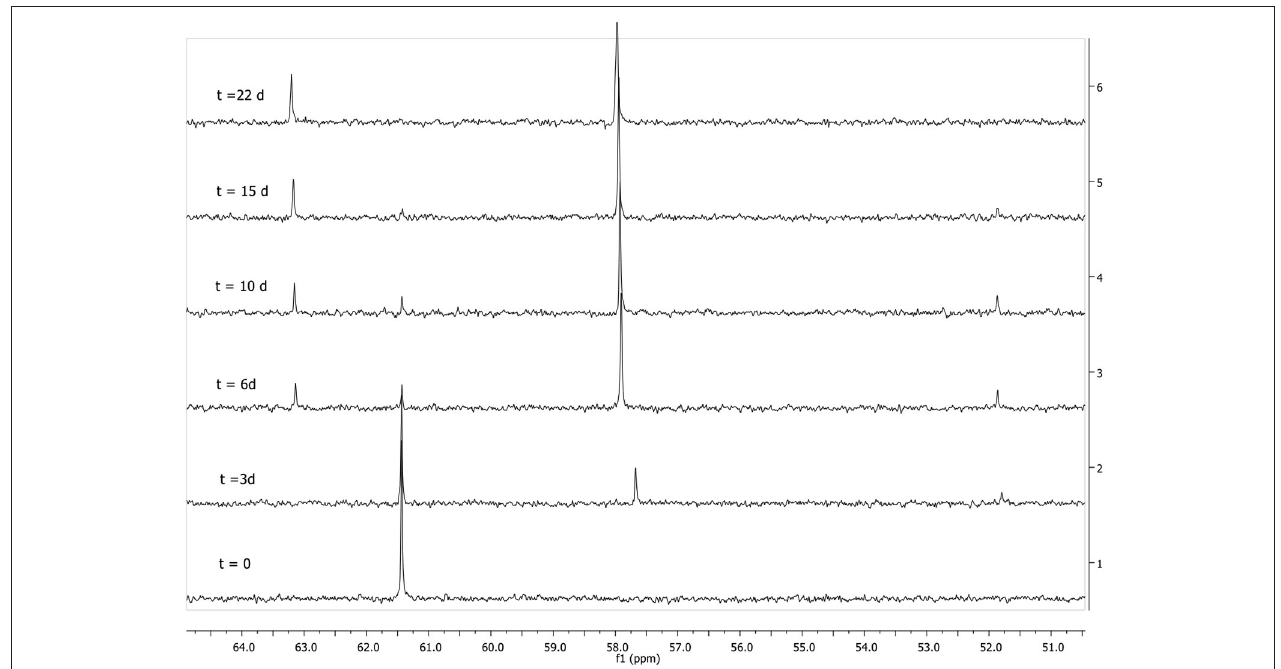
FIGURE 4 | Progressive 31 P NMR spectra obtained for degradation of 1 with piperidine (0.74M) at 25 ◦ C in 1,3-Dioxolane.